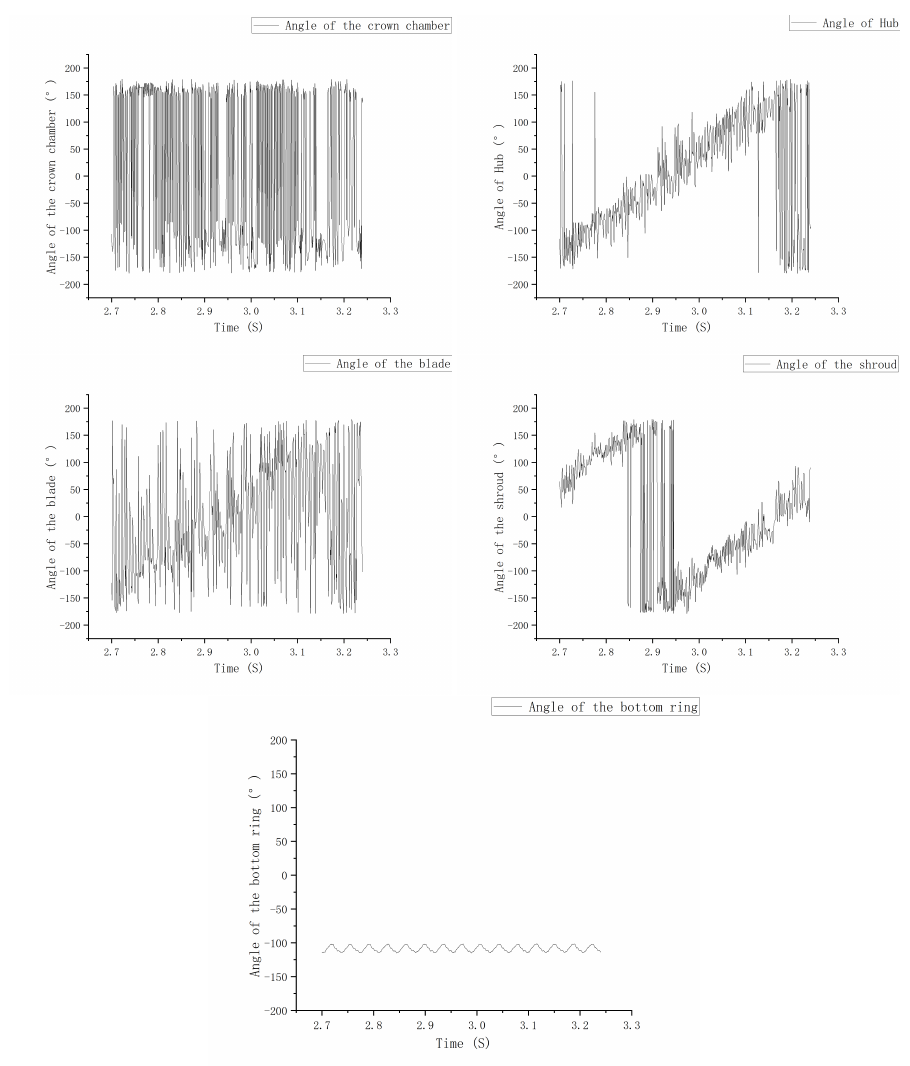
Figure 15. The phase angles of the radial force